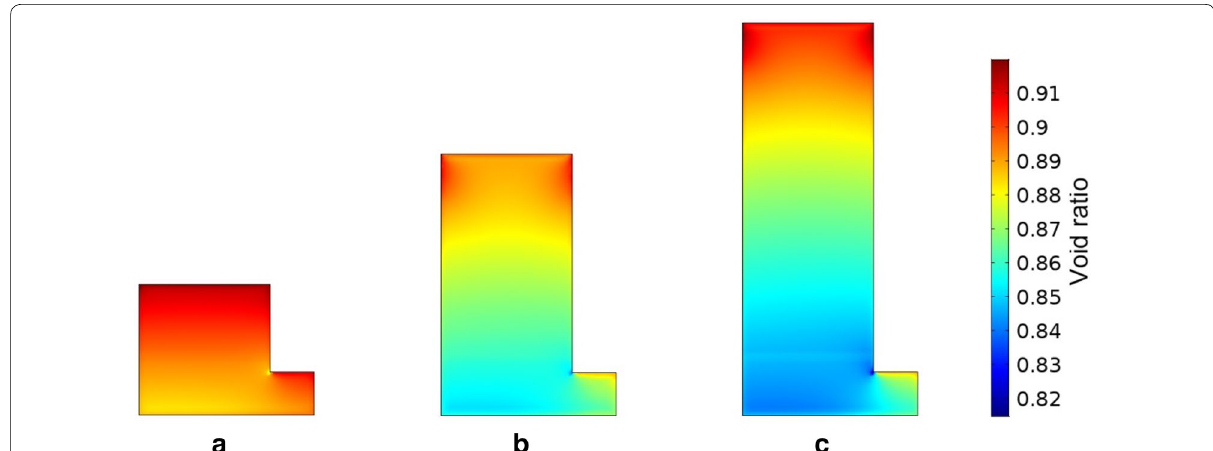
Fig. 14 Spatial distribution of void ratio of CPB with different H/W ratios after 7 days of curing: a 1:1 (15 m (45 m 15 m) ×